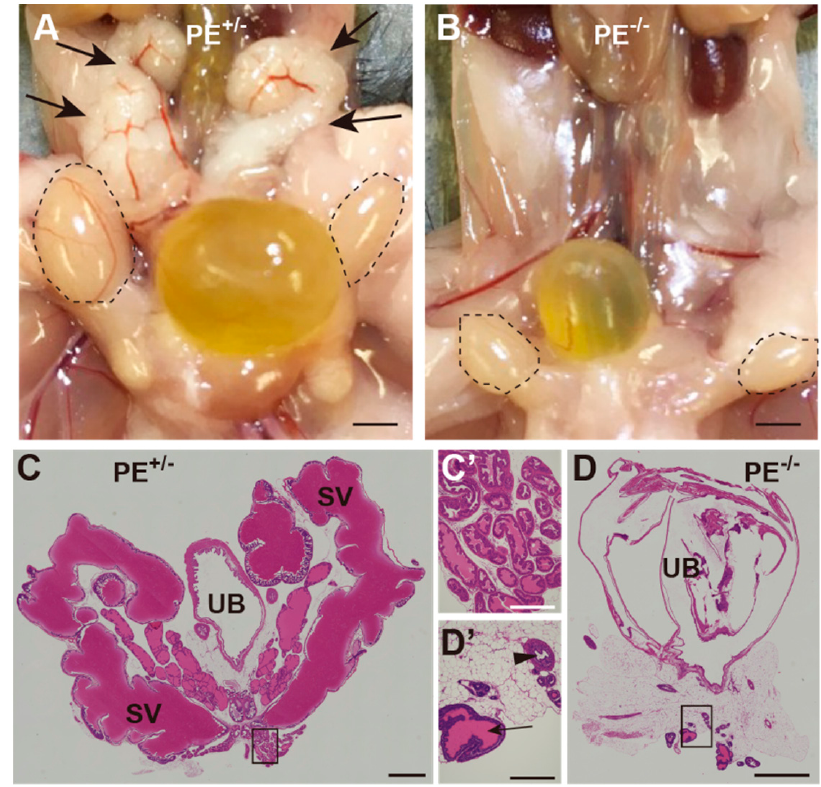
Figure 4. Hypoplastic development of reproductive organs in PE − / − male mice. ( A , B ) Macroscopic views of the lower abdominal organs in control ( A ) and PE − / − ( B ) mice. Testes are encircled by broken lines. Arrows in ( A ) indicate seminal vesicles, which were not observed in PE − / − mice ( B ). ( C , D ) HE-stained sections of the urinary bladder (UB) and seminal vesicles (SV) in control ( C ) and PE − / − ( D ) mice. ( C ’, D ’) Magnified view of the areas enclosed by open rectangles in ( C , D ). An arrow in ( D ’) indicates a rudimentary tissue of the prostate gland. An arrowhead in ( D ’) indicates the urethra. Scale bar: 2 mm in ( A – D ); 100 μ m in ( C ’, D ’).